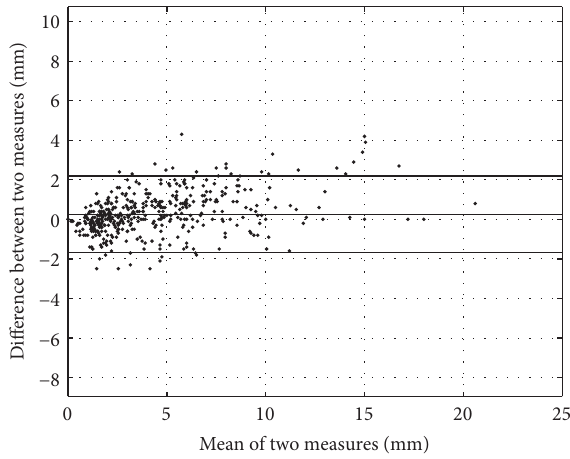
Figure 2: Bland and Altman plot of the two measurement methods (histology and MRI). The dashed line represents the mean value of the differences between the two measurement methods, and the lines above and below it represent the agreement interval.